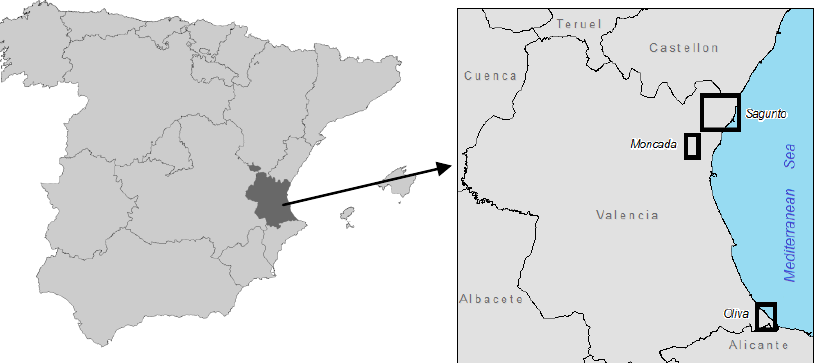
Figure 1. Location of the province of Valencia in Spain (left) and distribution of the three study areas (right).